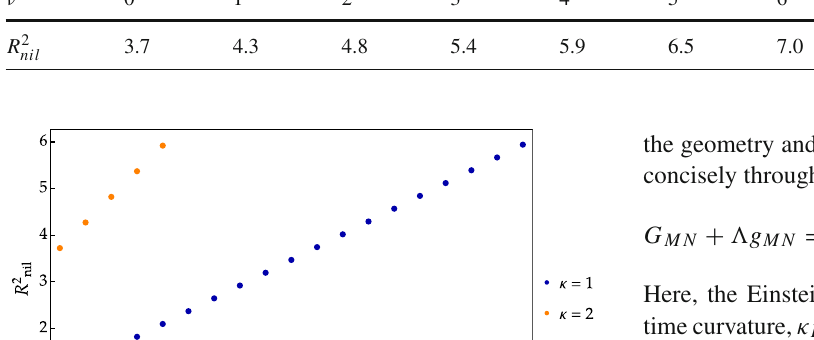
Table 2 The first few mass ratios R 2